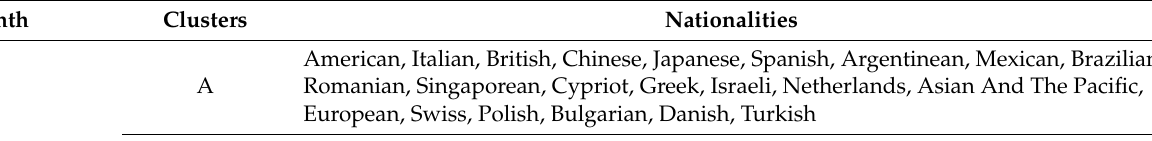
Table 1. Clusters content when the number of clusters is equal to ten (N = 10).